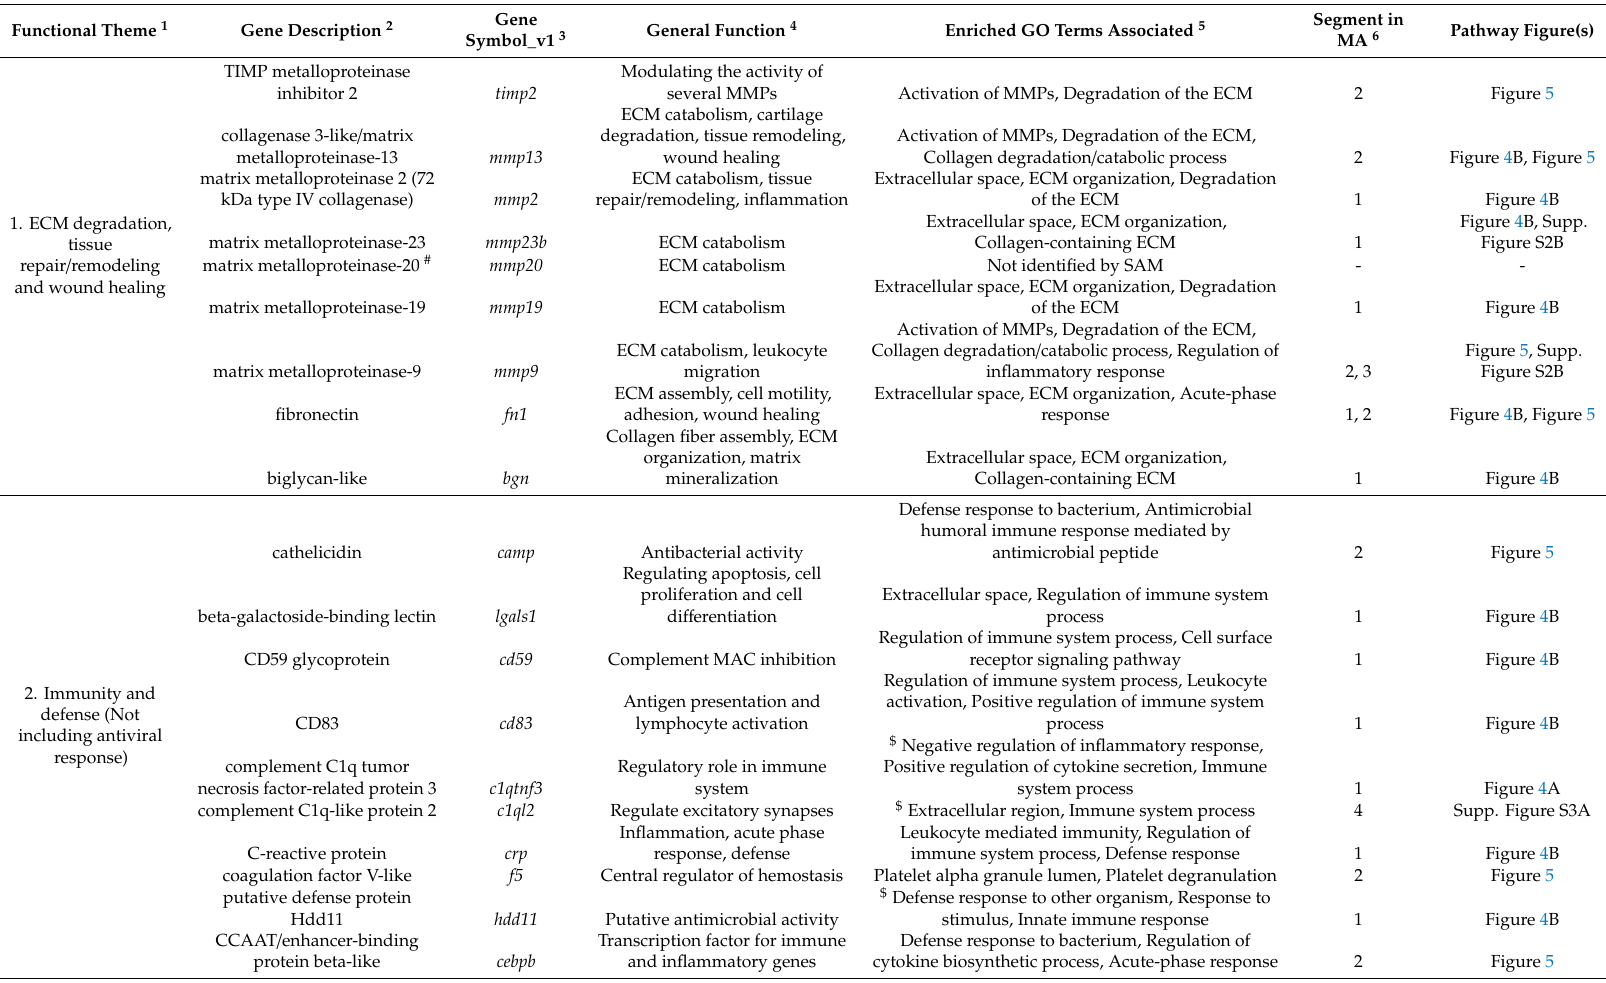
Table 3. Summary of details about the real-time quantitative polymerase chain reaction (QPCR)-analyzed genes of interest (GOIs) from di ff erent functional